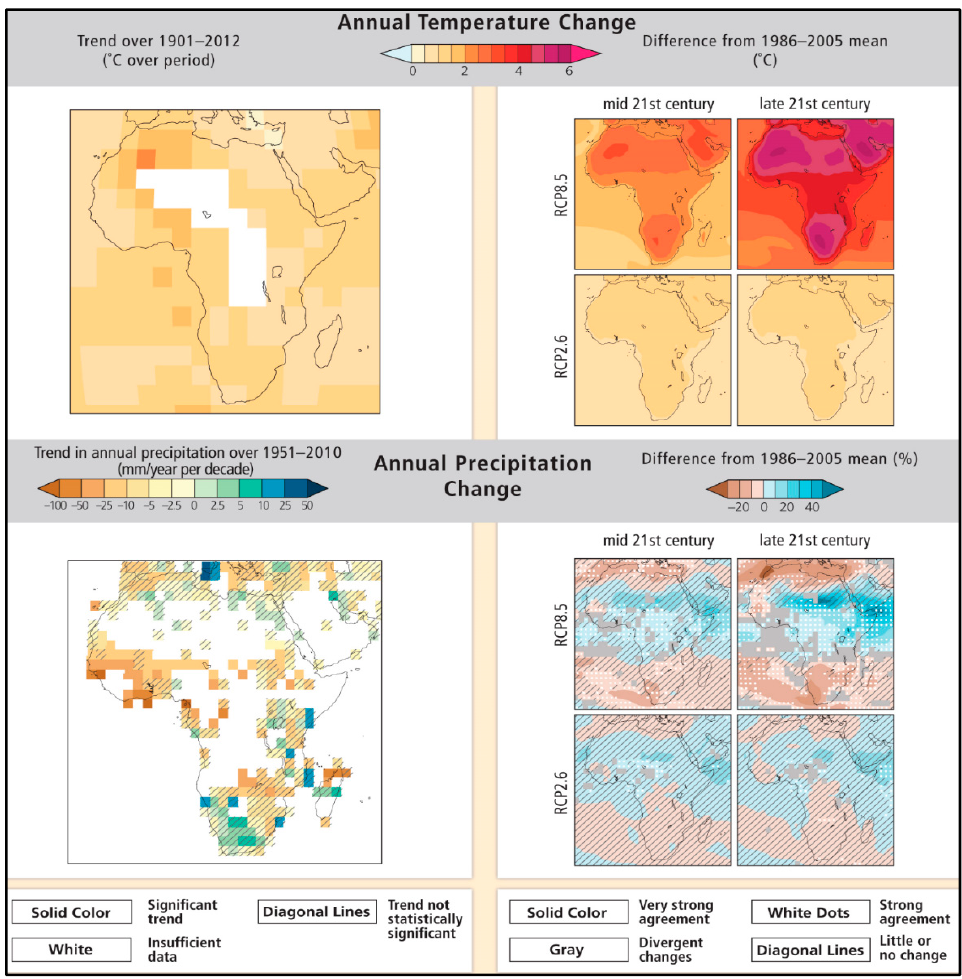
Figure 2. Observed and simulated variations in past and projected future annual average temperature and precipitation over Africa. The maps illustrate temperature and precipitation changes observed to date and projected warming under continued high emissions and under ambitious mitigation.